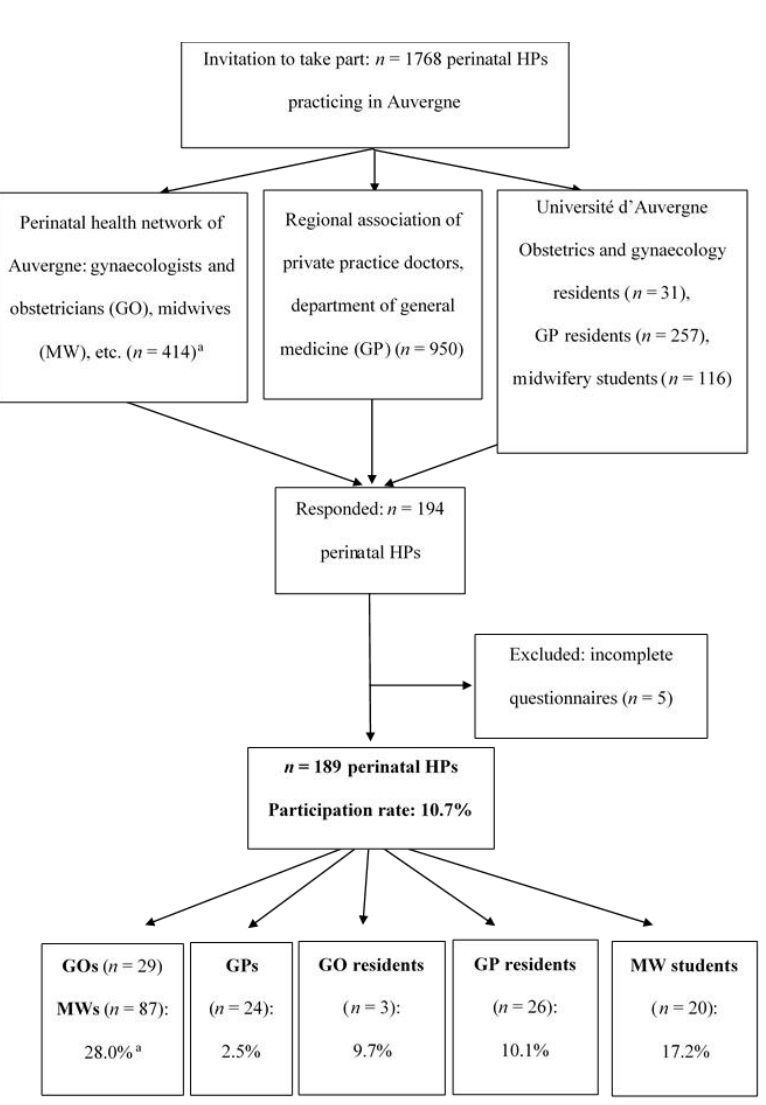
Figure 1. Participation rate of perinatal HPs in the PERI-HELPE study. GO,